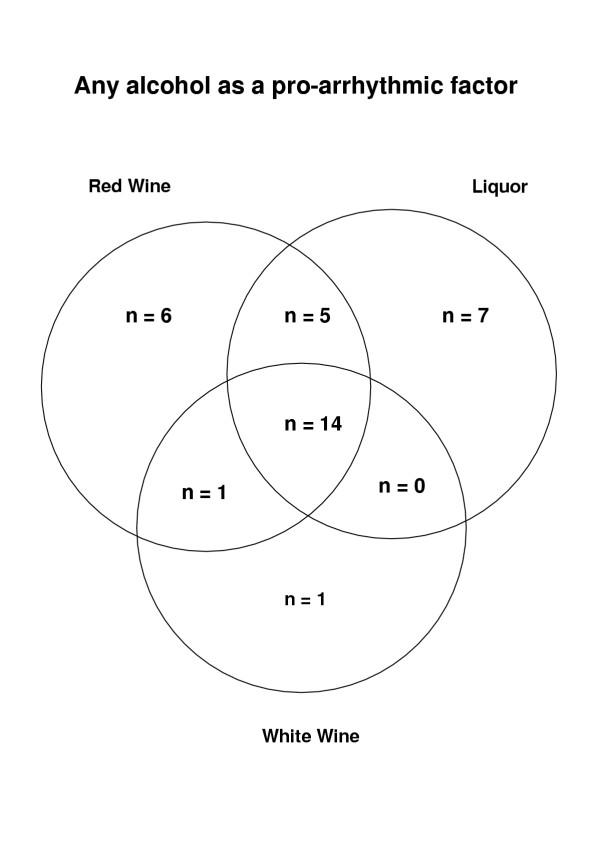
Any alcohol as a pro-arrhythmic factor. Thirty-four patients cited various forms of alcohol as a factor triggering arrhythmia. Some patients named more than one kind of alcohol. Twenty-six cited red wine, 26 spirits and 16 white wine. In this group, red wine and spirits caused significantly more episodes of arrhythmia than white wine.